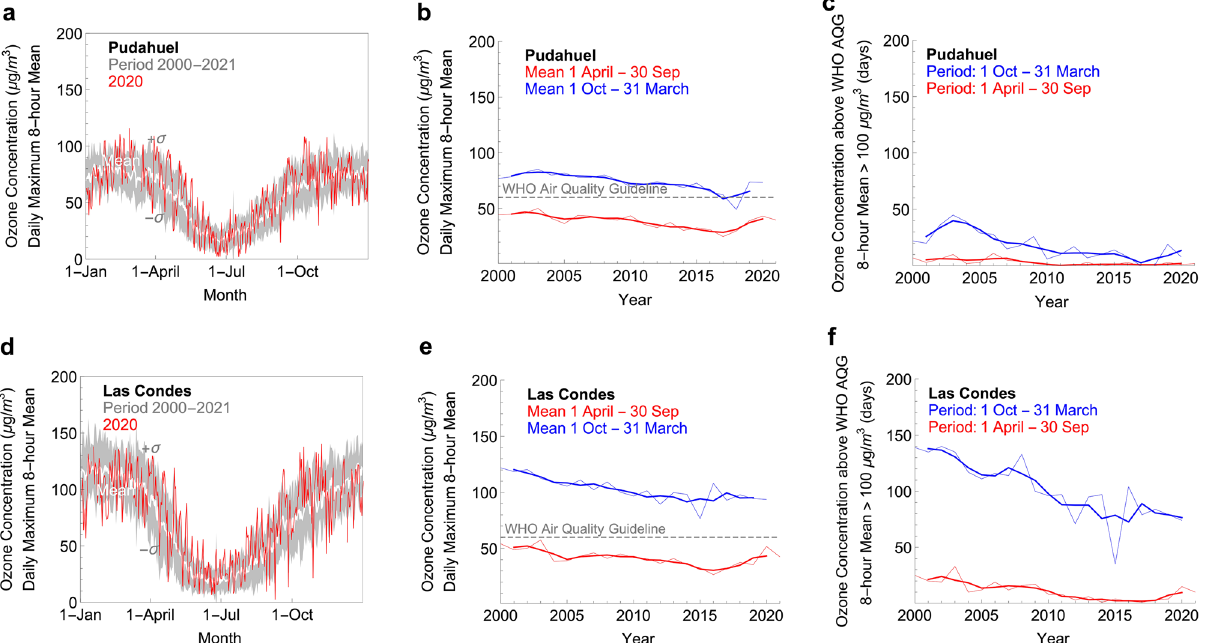
Figure 3. Ground-level ozone burden is considerably lower at Pudahuel (located on the deprived west side of the city) than at Las Condes (located in the affluent northeastern Santiago). ( a ) Daily maximum 8-h mean ozone concentration at Pudahuel station (33.44° S, 70.75° W, 460 m a.s.l., western Santiago). For each day of year (DOY), we formed datasets using daily maximum 8-h mean ozone concentrations over the period 2000–2021. The mean (white line) and standard deviation (bounds of the gray shading) of these datasets are shown in the plot. The daily maximum 8-h mean ozone concentration for 2017 is also shown (red line). ( b ) Progress of daily maximum 8-h mean ozone concentration at Pudahuel station (western Santiago) averaged over the period 1 April–30 Sep (red line) and over the period 1 Oct–31 March (blue line). Bold lines correspond to the 3-year centered moving averages. The dotted gray line indicates the 6-month peak season safe level (60 µg/ m 3 ) according to the air quality guidelines (AQG) by the World Health Organization (WHO) 24 . ( c ) Number of days at Pudahuel station (western Santiago) with a daily maximum 8-h mean ozone concentration higher than 100 µg/m 3 (which is the daily maximum 8-h mean safe level according to the WHO 24 . Bold lines correspond to the 3-year centered moving averages. ( d ) Daily maximum 8-h mean ozone concentration at Las Condes station (33.38° S, 70.52° W, 795 m a.s.l., northeastern Santiago). For each day of year (DOY), we formed datasets using daily maximum 8-h mean ozone concentrations over the period 2000–2021. The mean (white line) and standard deviation (bounds of the gray shading) of these datasets are shown in the plot. The daily maximum 8-h mean ozone concentration for 2017 is also shown (red line). No measurements were conducted in February 2017 due to maintenance of the station. ( e ) Progress of daily maximum 8-h mean ozone concentration at Las Condes station (northeastern Santiago) averaged over the period 1 April–30 Sep (red line) and over the period 1 Oct–31 March (blue line). Bold lines correspond to the 3-year centered moving averages. The dotted gray line indicates the 6-month peak season safe level (60 µg/m 3 ) according to the WHO 24 . ( f ) Number of days at Las Condes station (northeastern Santiago). with a daily maximum 8-h mean ozone concentration higher than 100 µg/m 3 (which is the daily maximum 8-h mean safe level according to the WHO 24 . Bold lines correspond to the 3-year centered moving averages. Ozone measurements are from the air quality monitoring network operated by the Chilean Ministry of Environment (MMA) available at: https:// sinca. mma. gob. cl/ index. php/ region/ index/ id/M. Plots were generated using Python’s Matplotlib library 50